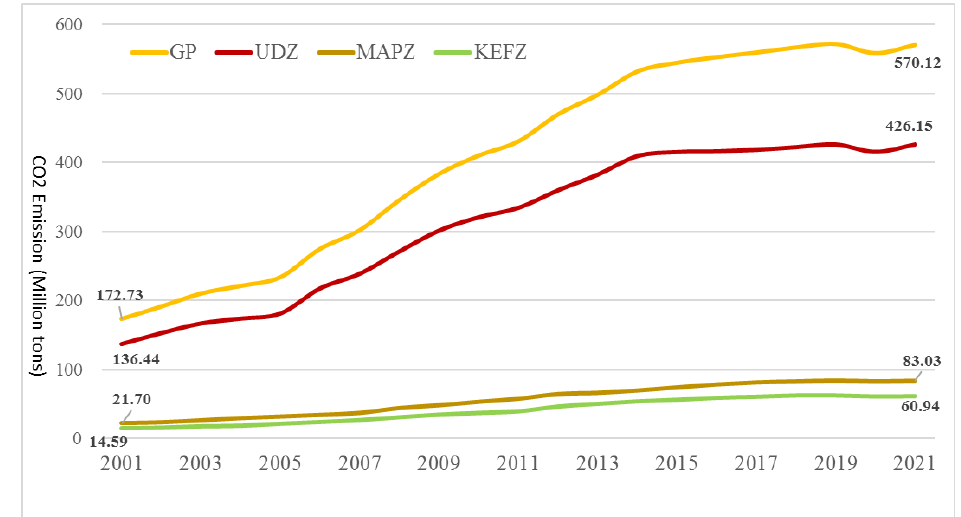
Figure 3. Changes in total carbon emissions from the three types of major function-oriented zones (MFOZs) in Guangdong Province from 2001 to 2021.